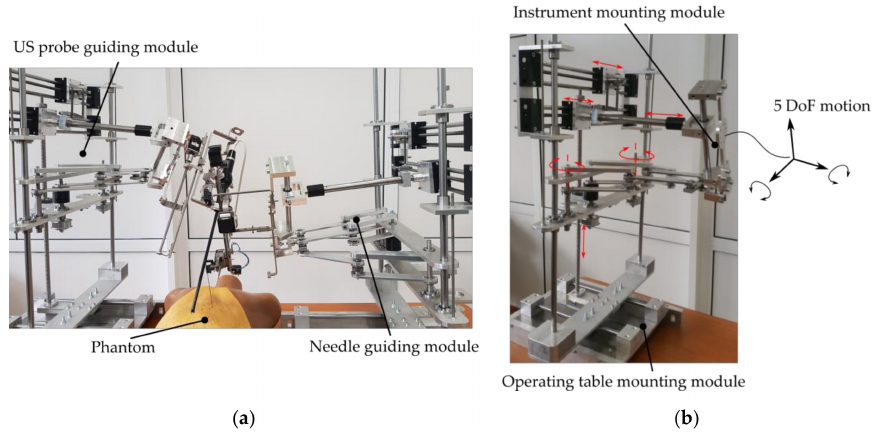
Figure 1. ProHep-LCT robotic system: ( a ) robotic system in “mirrored” configuration; ( b ) one module guiding of the robotic system.